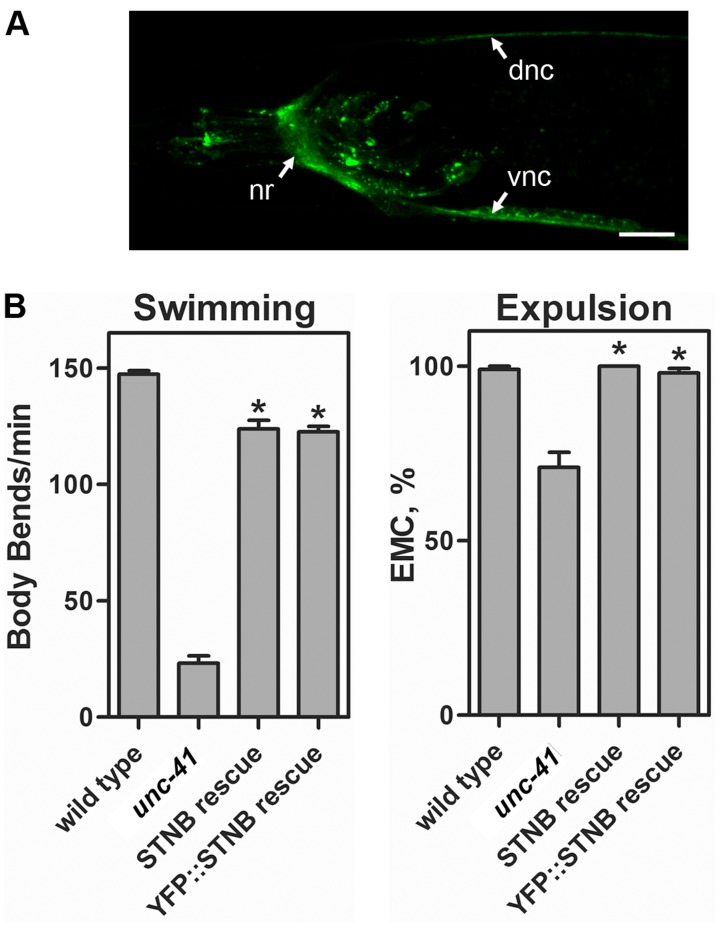
Phenotypic rescue of unc-41 mutants by transgenic expression of Drosophila stoned B (STNB).(A) A YFP::STNB fusion protein is correctly trafficked and localized to synaptic regions. Shown is the head of a young adult hermaphrodite; anterior is to the left, and the scale bar is 10 µm. STNB is specifically associated with synaptic regions, including the nerve ring (nr) and dorsal (dnc) and ventral (vnc) nerve cords. (B) Behavioral analyses of young adult hermaphrodites expressing STNB or YFP::STNB transgenes. The strains analyzed were (from left to right) RM2086, RM2655, RM2683, and RM3644; genotypes are provided in List S1. Details of swimming and expulsion assays are in Materials and Methods. For swimming assays, each bar represents the mean number of body bends/min for 20 individuals of each strain. For expulsion assays, each bar represents the percentage of defecation cycles ending with an enteric muscle contraction (EMC, %) for 10 individuals of each strain. Error bars indicate SEM. Asterisks denote significant difference from unc-41 (P<0.0001).